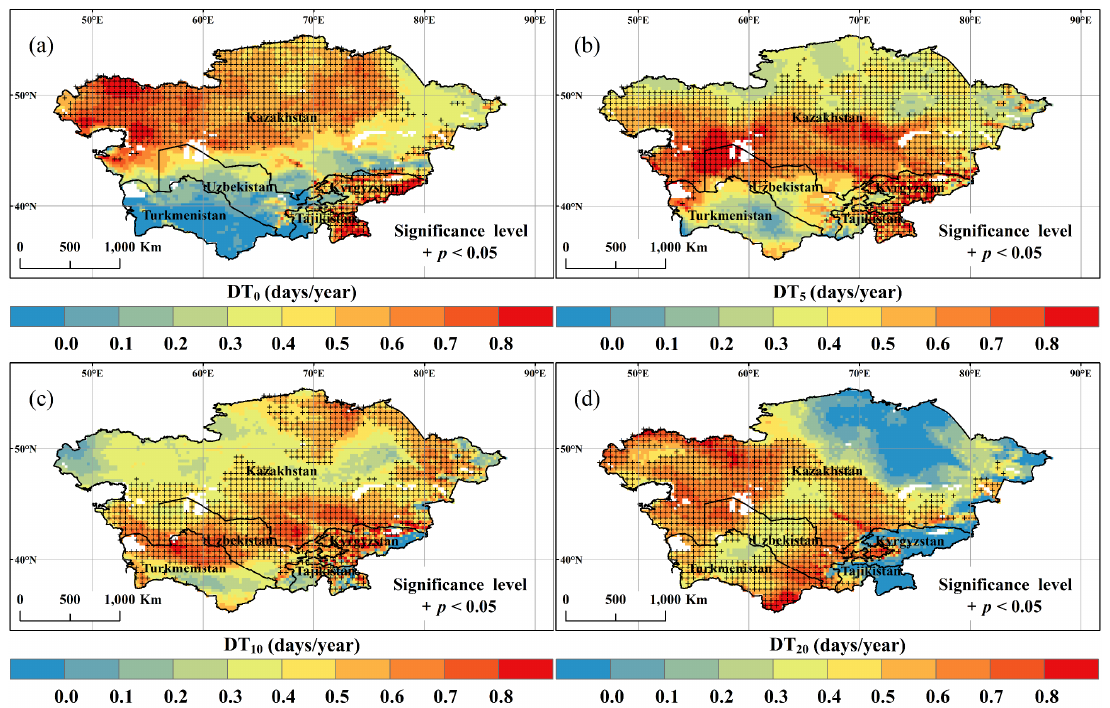
Figure 6. Spatial distribution of trends in ( a ) DT 0 , ( b ) DT 5 , ( c ) DT 10 , and ( d ) DT 20 during the period 1982–2014.